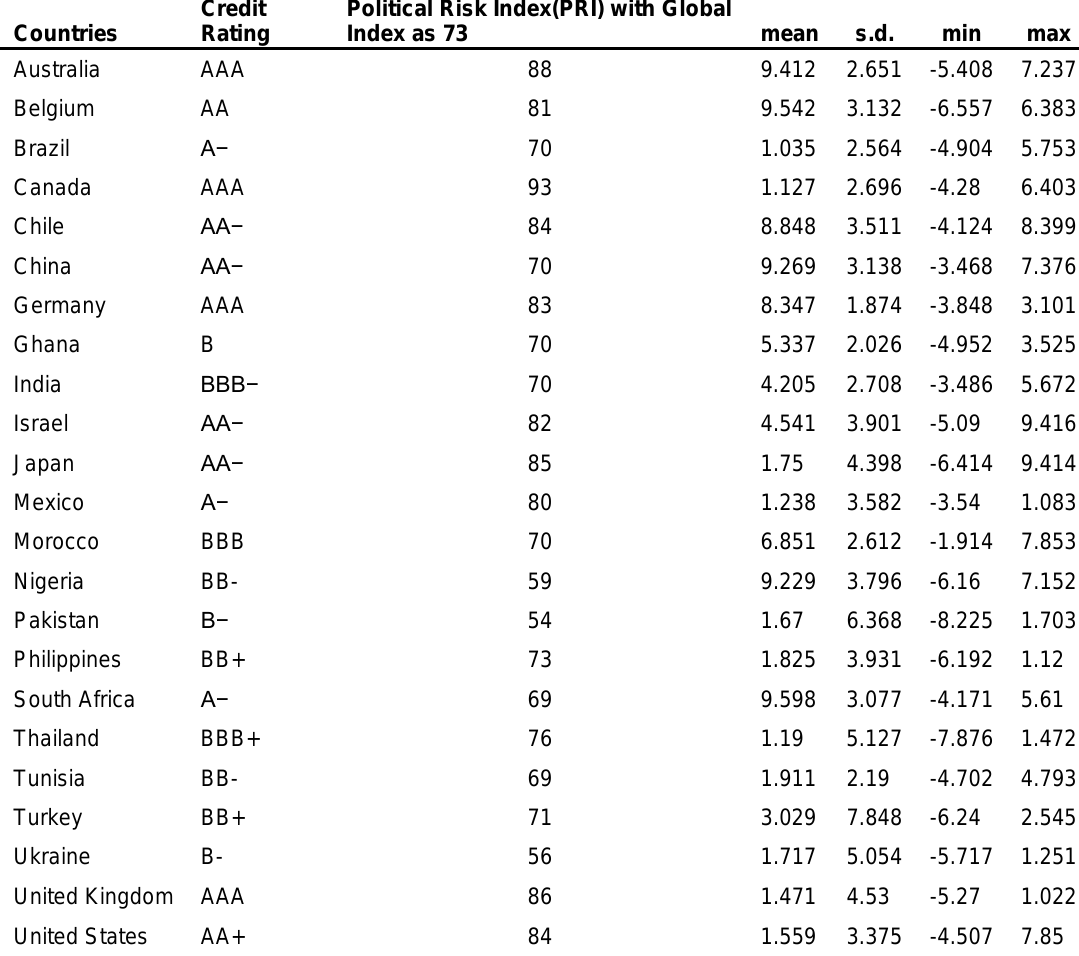
Table 2: Summary statistics of stock returns from 1996 to